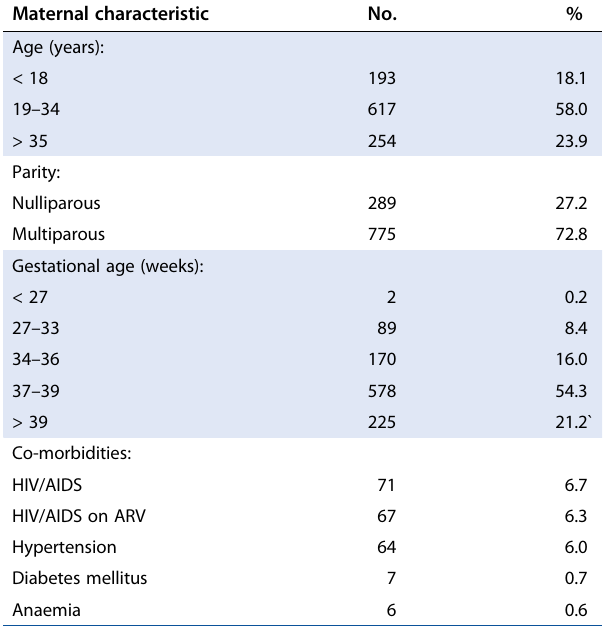
Table 3: Surgical procedure Variable